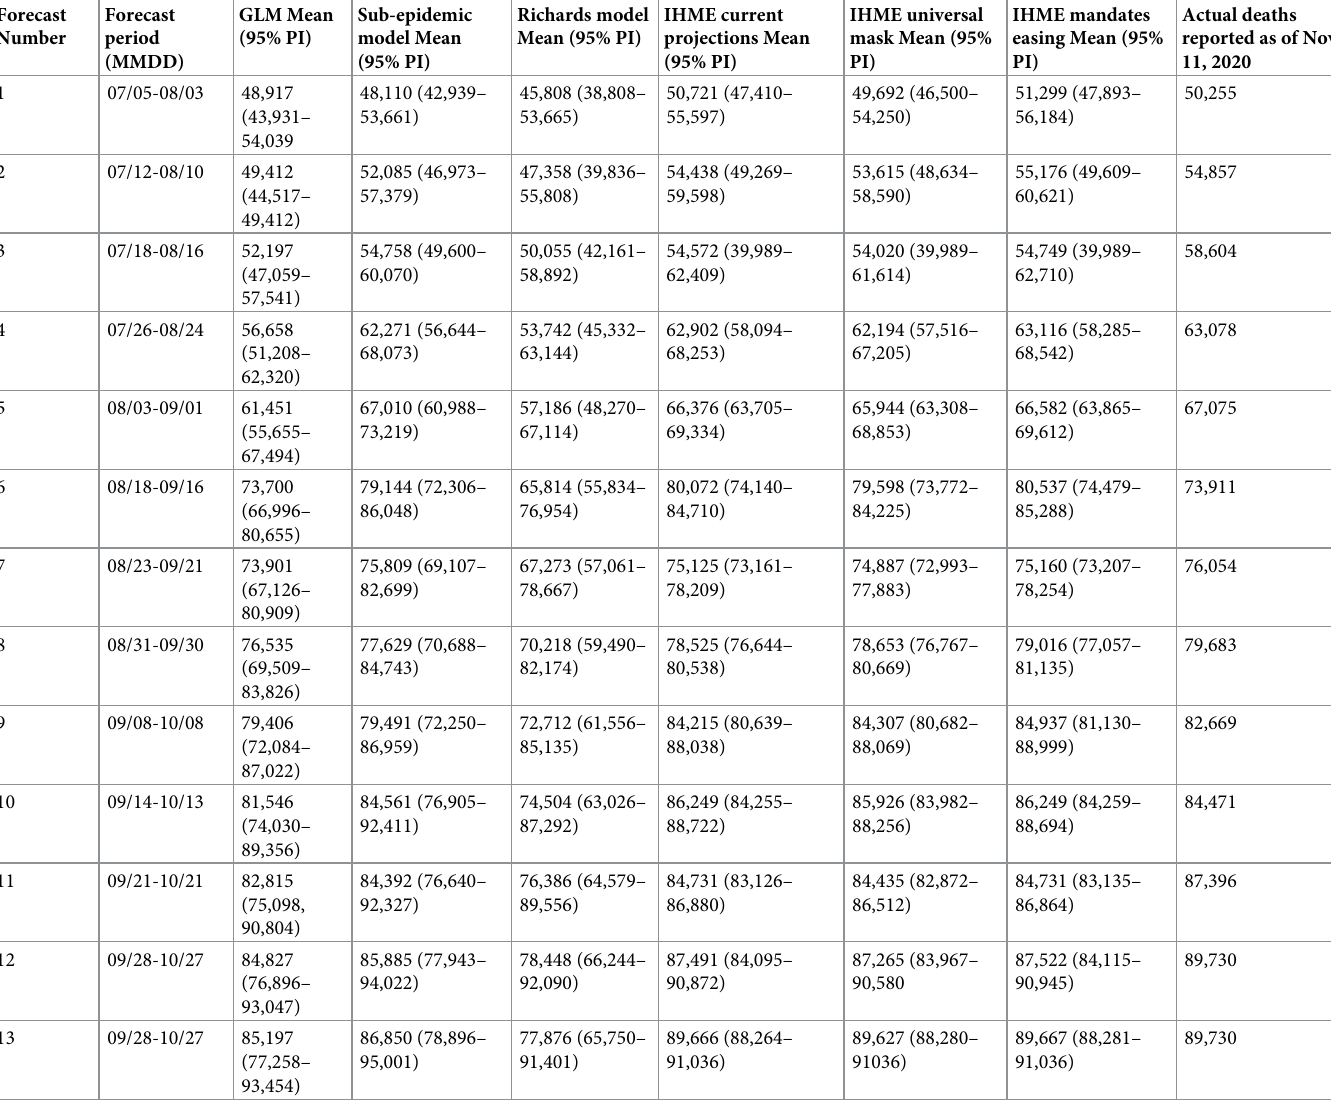
Table 2. Cumulative mortality estimates obtained from the six models (GLM, Richards model, sub-epidemic model, IHME current projections, IHME universal mask and IHME mandates easing) at the end of each forecasting period for the COVID-19 pandemic in Mexico (2020). Forecast